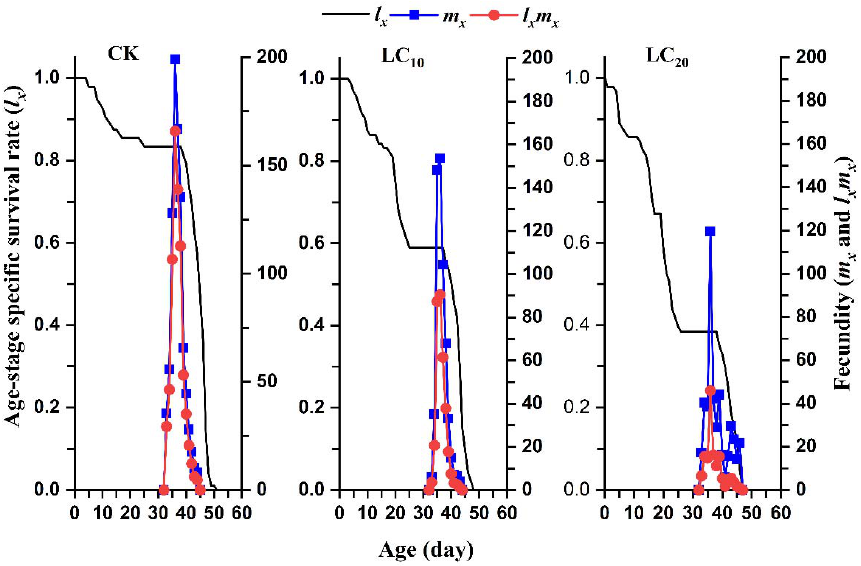
Figure 1. Age-stage specific survival rate ( S xj ) of FAW exposed to sublethal concentrations (LC 10 and LC 20 ).